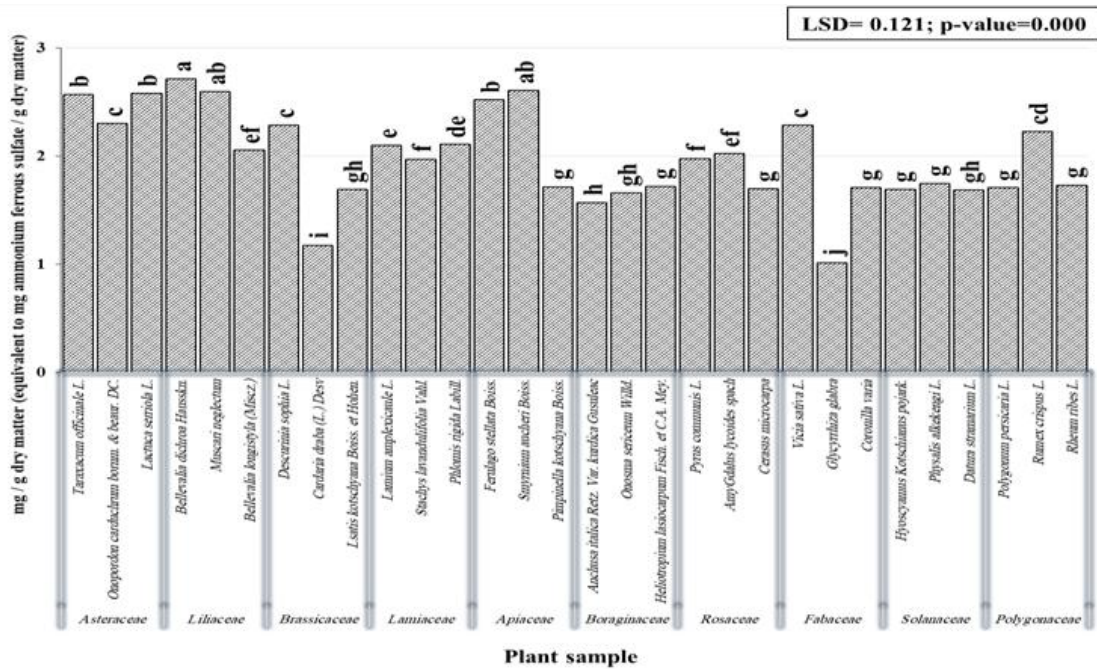
Fig. 4. Antioxidant capacity of studied plant species depending on plant family by FRAP